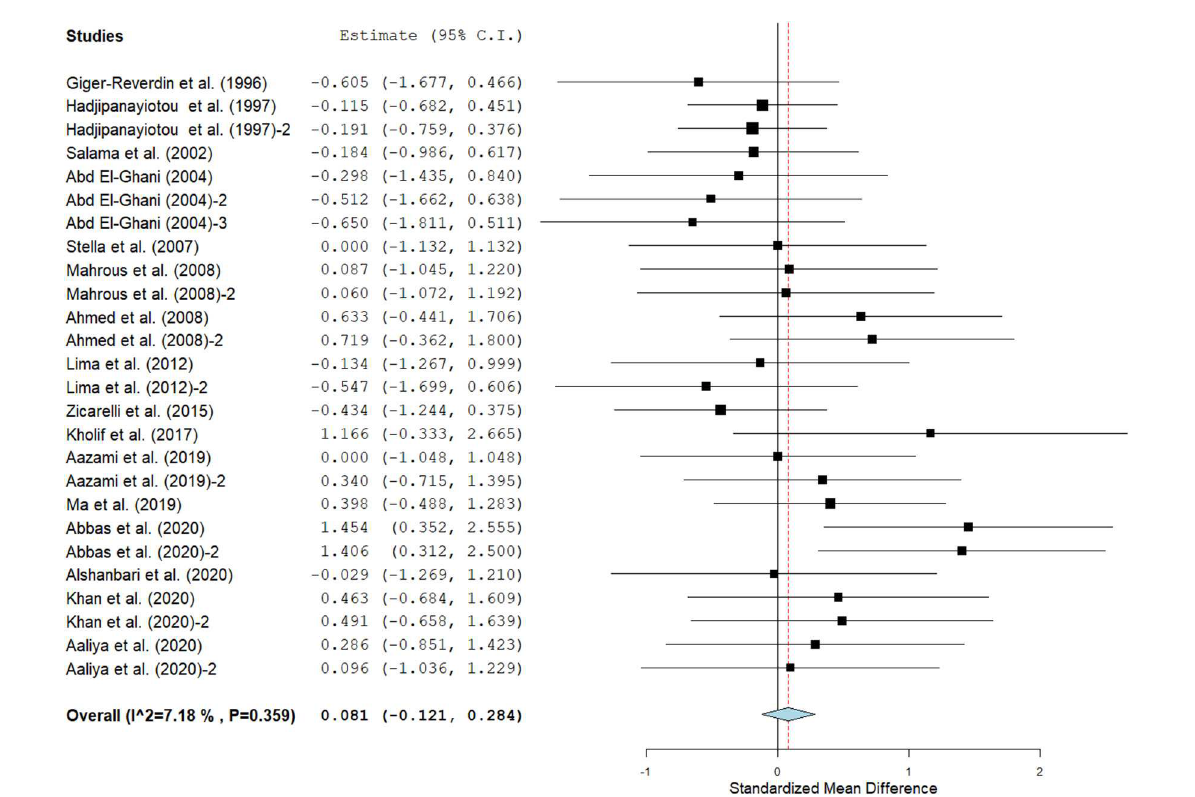
FIGURE4 Effect of SC on milk proteins in lactating does. The error bars connote the SMD of each trial, while the upper and lower 95% CIs for the effect size are the line that joined the individual square box. The thick vertical line is the line of no effect (SMD = 0), which suggests no effect of SC treatment on milk proteins. The sky-blue diamond at the base of the plot indicates the pooled SMD with its width representing the 95% confidence intervals for the effect size. The points to the right of the line of no effect suggest an increase in milk proteins. The points to the left of the line of no effect connote an increase in milk proteins. I 2 is the inconsistency index.